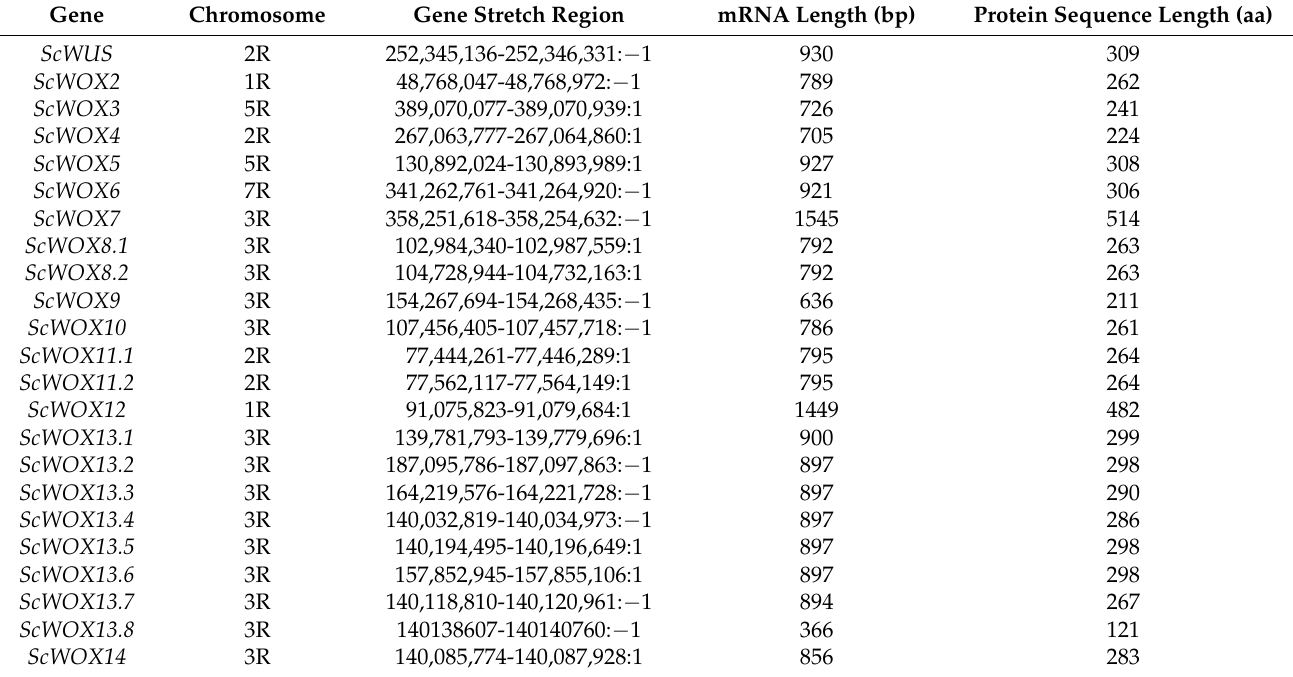
Table 3. Characteristics of ScWOX gene family members in S. cereal .